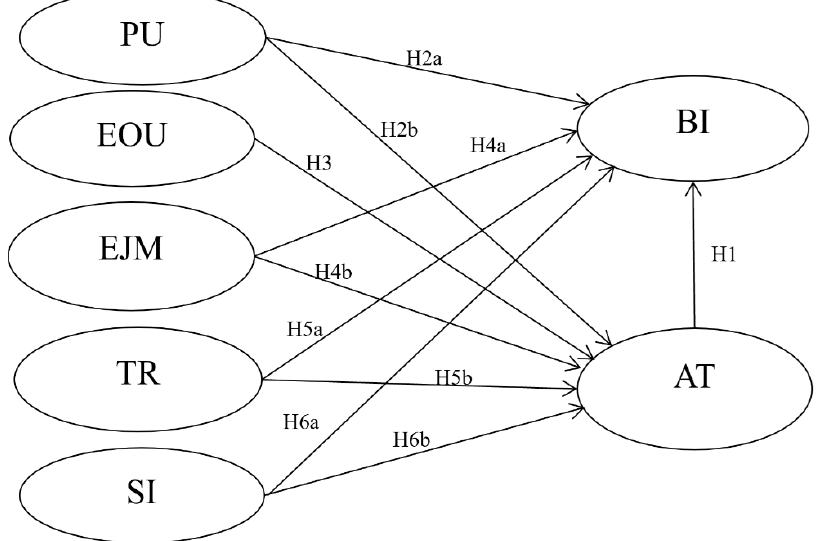
Figure 1. Research model. Note: PU = perceived usefulness; EOU = perceived ease of use; EJM = enjoyment; TR = trust; SI = social influence; AT= attitude; BI=behavior intention.